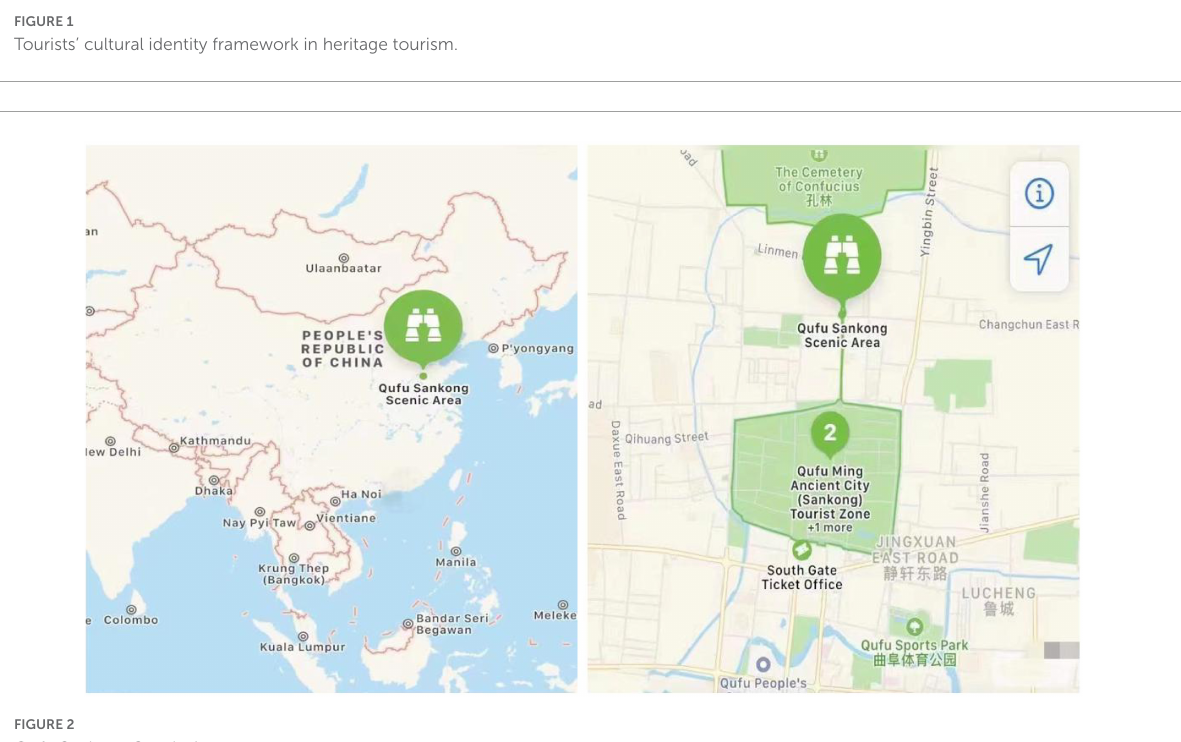
FIGURE2 Qufu Sankong Scenic